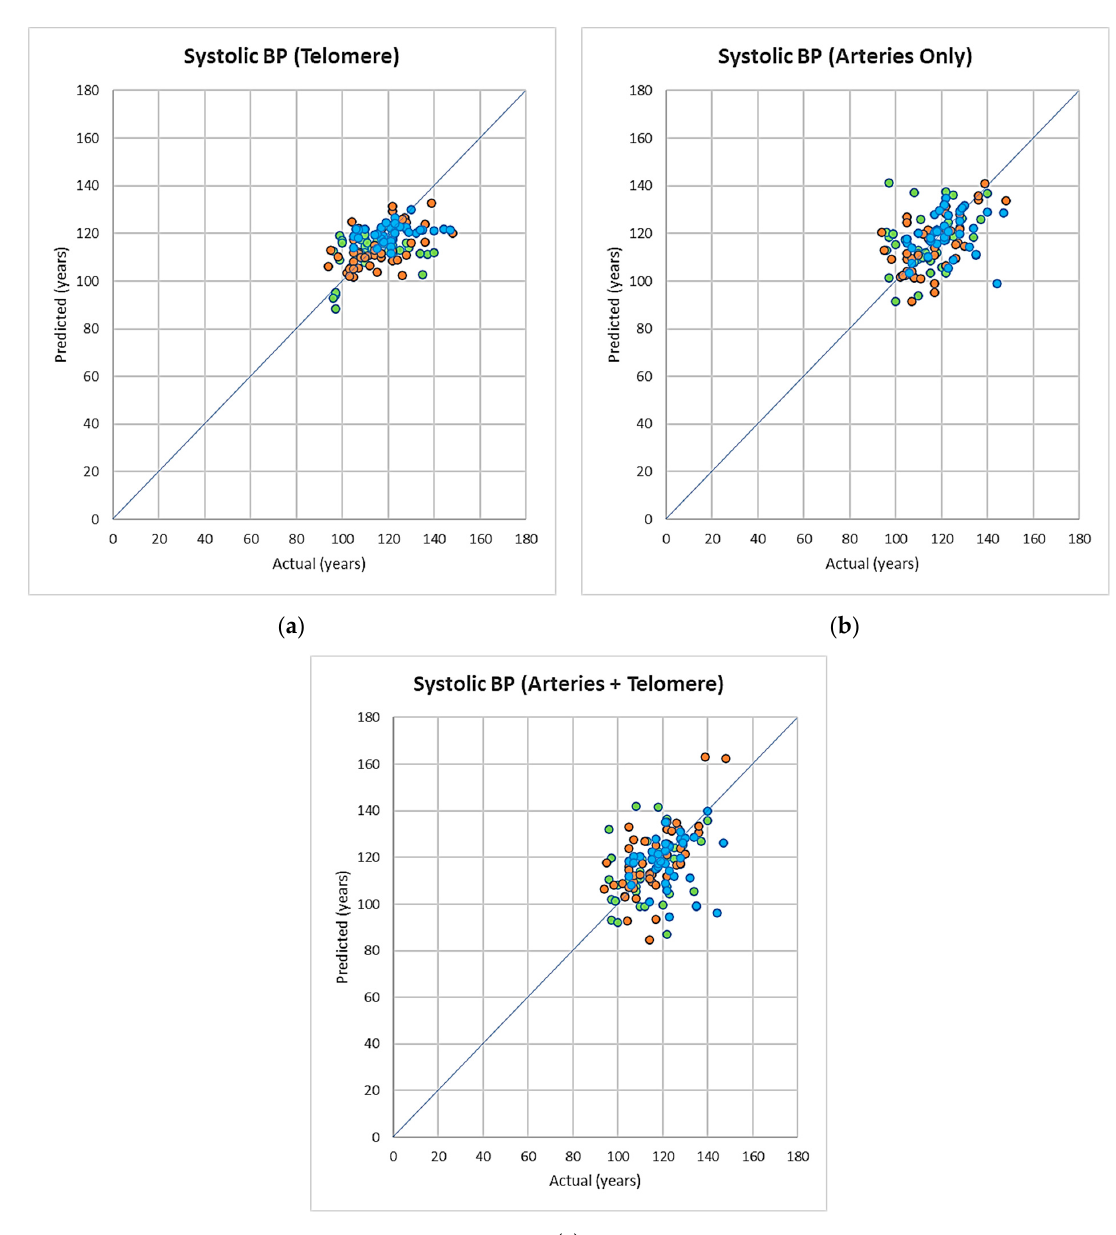
Figure 4. ( a – c ) Predicted systolic blood pressure vs. actual systolic blood pressure using models based on artery, telomere, artery + telomeres combined data, colour coded for the different age groups (green: 18–30, orange: 31–50, blue: 50+). Table 6. ( a ) Mean absolute errors for diastolic BP predictions (Age group 1). ( b ) Mean absolute er- rors for diastolic BP predictions (Age group 2). ( c ) Mean absolute errors for diastolic BP predictions (age group 3).